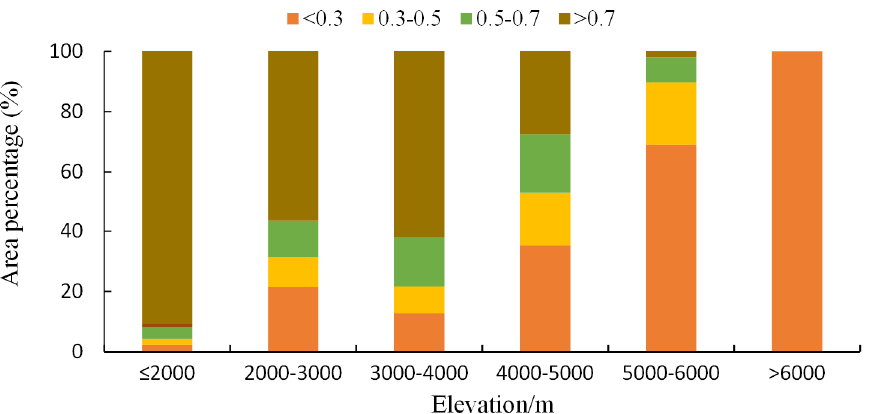
Figure 5. Area percentage of FVC at different elevation levels on the Qinghai–Tibet Plateau.